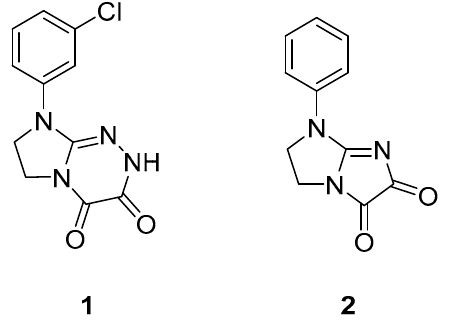
Figure 1. Structural formulas of the investigated compounds.